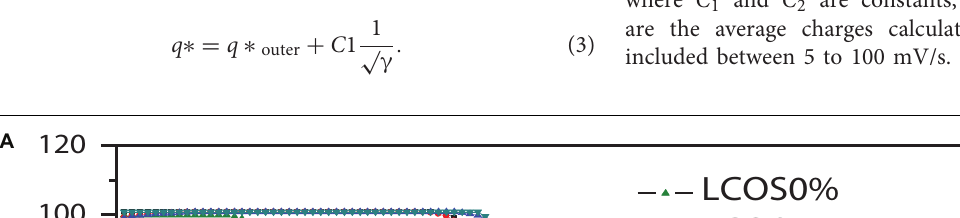
Frontiers in Materials |